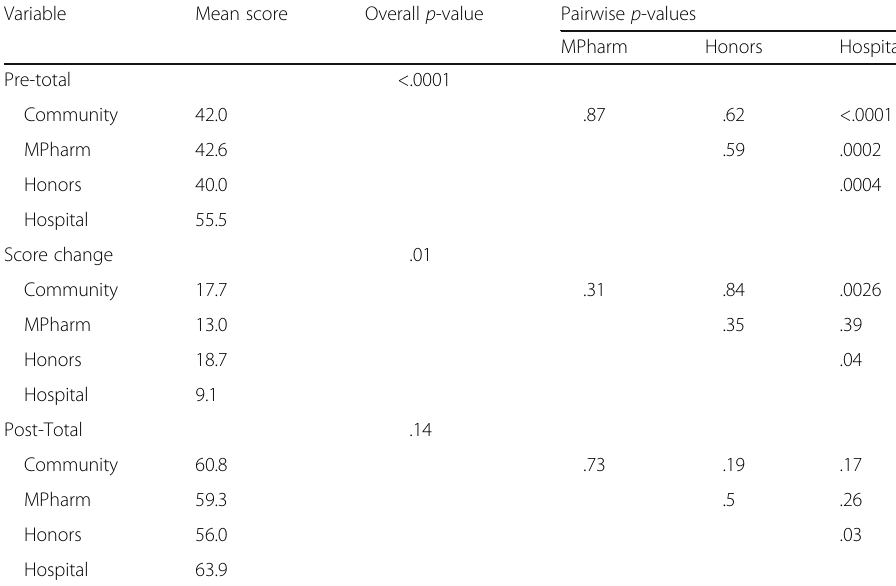
Table 5 Total scores on confidence statements, and pairwise differences between student types (obtained from the GLM)